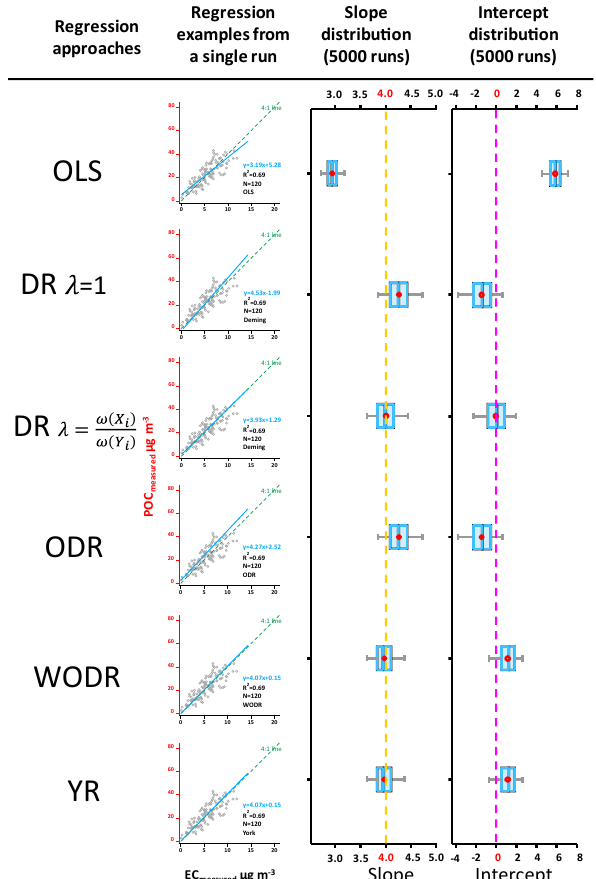
Figure 5. Regression results on synthetic data, Case 1 (Slope = 4, Intercept = 0, LOD POC = 1, LOD EC = 1, a POC = 1, a EC = 1, R 2 (POC, EC) = 0.67 ± 0.03). The scatter plots demonstrate regression examples from a single run. The box plots show the distribution of regressed slopes and intercepts from 5000 runs of six regression ap- proaches. The dashed lines in orange and pink represent true slope and intercept,